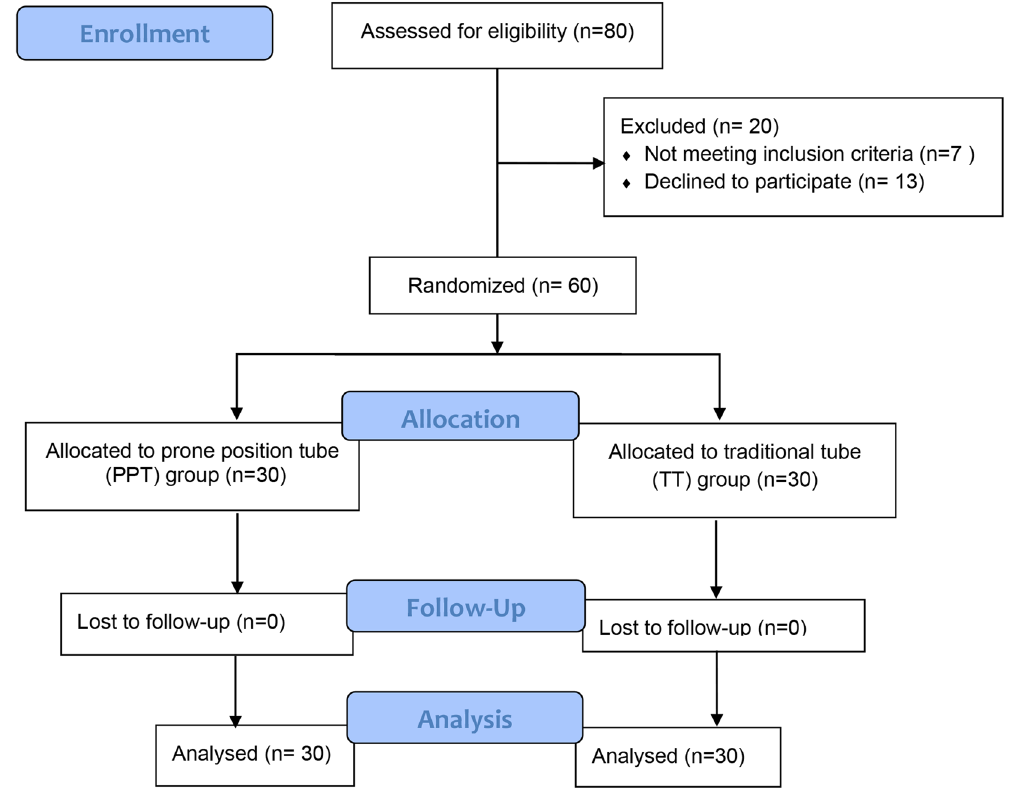
Figure 2. Trial flow diagram.